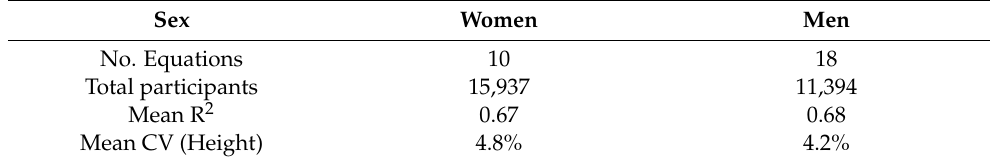
Table 5. Totals and averages of parameters of eqs of the family maximum height = β o + β 1 · KH + ε . Sex Women Men No. Equations 10 18 Total participants 15,937 11,394 Mean R 2 0.67 0.68 Mean CV (Height) 4.8% 4.2%